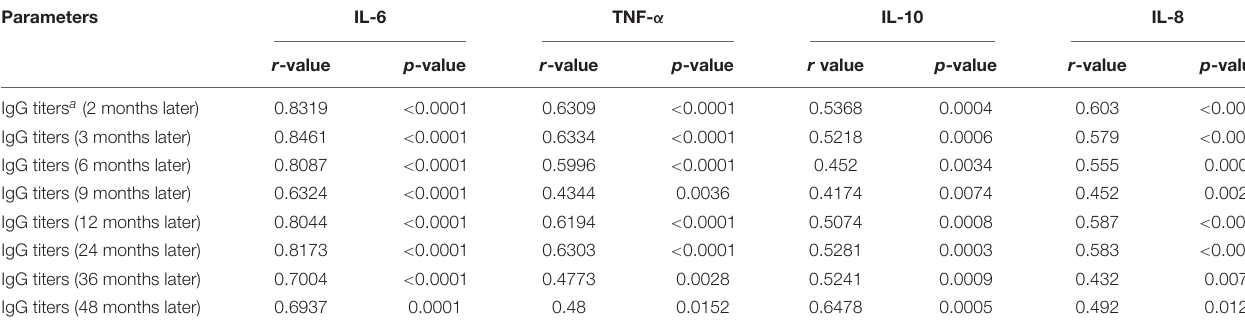
TABLE 2 | Correlation matrix of IgG titers with inflammatory factors in patients with severe fever with thrombocytopenia syndrome. Parameters